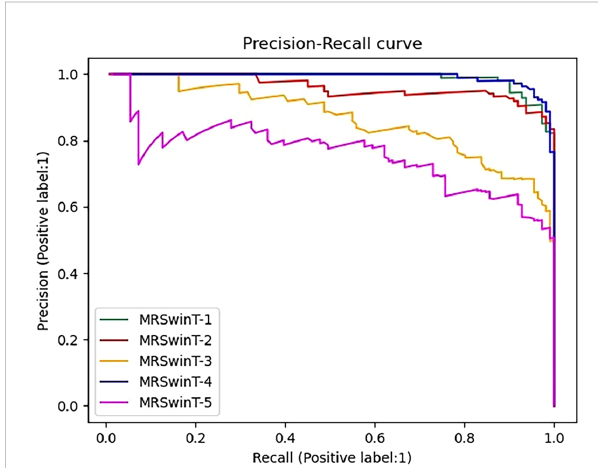
FIGURE 7 Precision-Recall curve. The label is 1, which means the infested root system is the positive sample. MRSWinT-1, MRSWinT-2, MRSWinT-3, MRSWinT-4, and MRSWinT-5 represent the original dataset, denoised dataset only, segmented dataset only, denoised-then-segmented dataset, and segmented-then-denoised dataset, respectively.